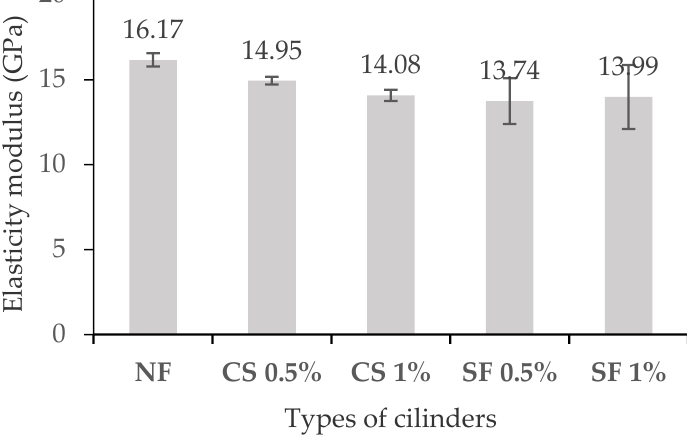
Figure 7. Modulus of elasticity for design strength of 23.54 MPa.